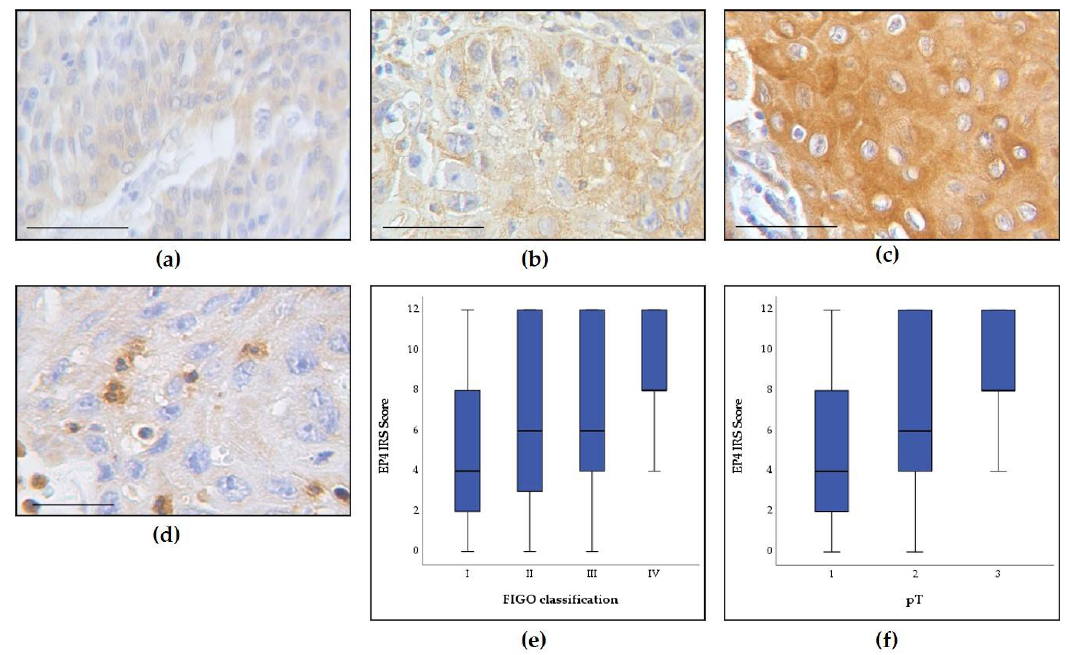
Figure 1. EP4 expression depending on tumor size and FIGO status. Immunohistochemical staining of EP4 in ( a ) vulvar cancer with weak expression (immunoreactivity score (IRS) 4), ( b ) vulvar cancer with moderate expression (IRS 6) and ( c ) vulvar cancer with strong expression (IRS 12). ( d ) Vulvar cancer with tumor-associated macrophages. ( e , f ) EP4 expression correlates with FIGO classification ( p = 0.014) and tumor size ( p < 0.001). Magnification and scale bars ( a – c ) x 25 with scale bar representing 100 µm and ( d ) x 40 with scale bar representing 50 µm.